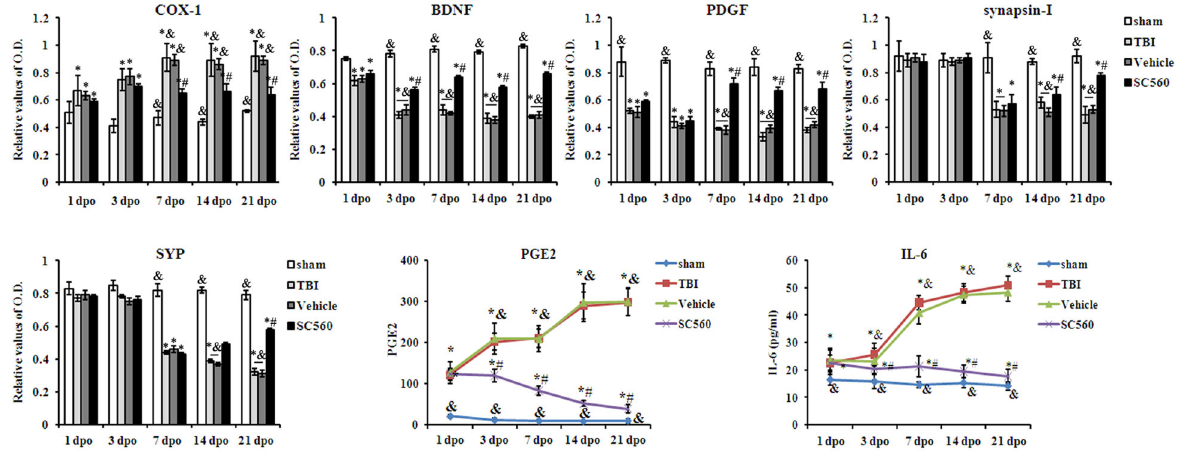
Figure 5. Effect of SC560 treatment on the expressions of multiple proteins. Data showed that compared with the sham group, traumatic brain injury (TBI) induced significant increases in COX-1, prostaglandin E2 (PGE2, pg ? mL -1 ? mg tissue -1 ) and interleukin (IL)-6 (ELISA), decreases in brain-derived neurotrophic factor (BDNF), platelet-derived growth factor BB (PDGF), synapsin-I and synaptophysin (SYP) protein levels (P , 0.05). Systemic administration with SC560 attenuated the increase of COX-1 at 7 dpo as well as that of PGE2 and IL-6 at 3 dpo and reversed the declines of BDNF, PDGF-BB, synapsin-I andSYP protein levels(P . 0.05).Dataare reportedasmeans±SD (n=8). dpo: dayspostoperation; O.D.:absorbanceat 280 nmforWesternblot,at 405 nmforPGE2ELISAandat450 nmforIL-6ELISAdetections, respectively. & P , 0.05, comparedtoSC560-treatedgroup; *P , 0.05,comparedtoshamgroup; # P , 0.05, comparedtovehicle-treatedgroup (two-way AVOVA and post hoc